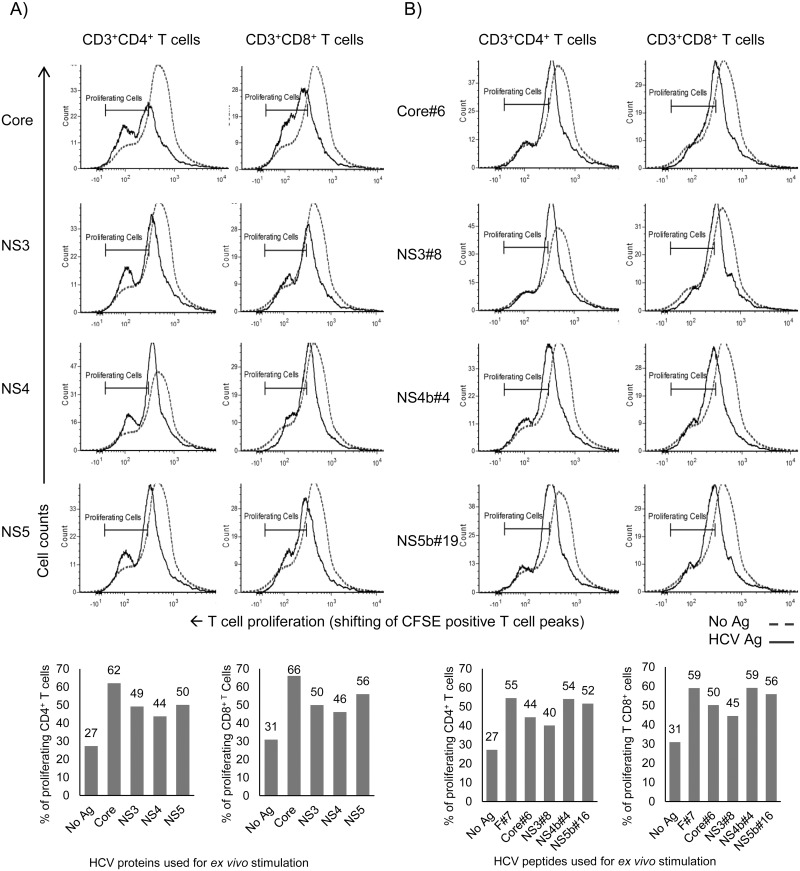
Cross-reactive CD4+ and CD8+ T cells obtained from Ad vector immunized mice proliferate in HCV antigens-dependent manner.Splenocytes obtained from Ad vector immunized mice were stimulated ex vivo with various recombinant HCV antigens (core, NS3, NS4 and NS5) or their selected respective peptides (at 5 μg/ml each), and analyzed by flow cytometry. Proliferation of CD4+ and CD8+ T cells stimulated ex vivo with: (A) HCV proteins; (B) Representative peptides derived from HCV proteins using the CFSE-based assay (loss of CFSE due to cell division represented by shift of peak of CFSE+ T cells towards left). Data are obtained from a pool (n = 5) of spleen cells and are representative of two independent experiments.